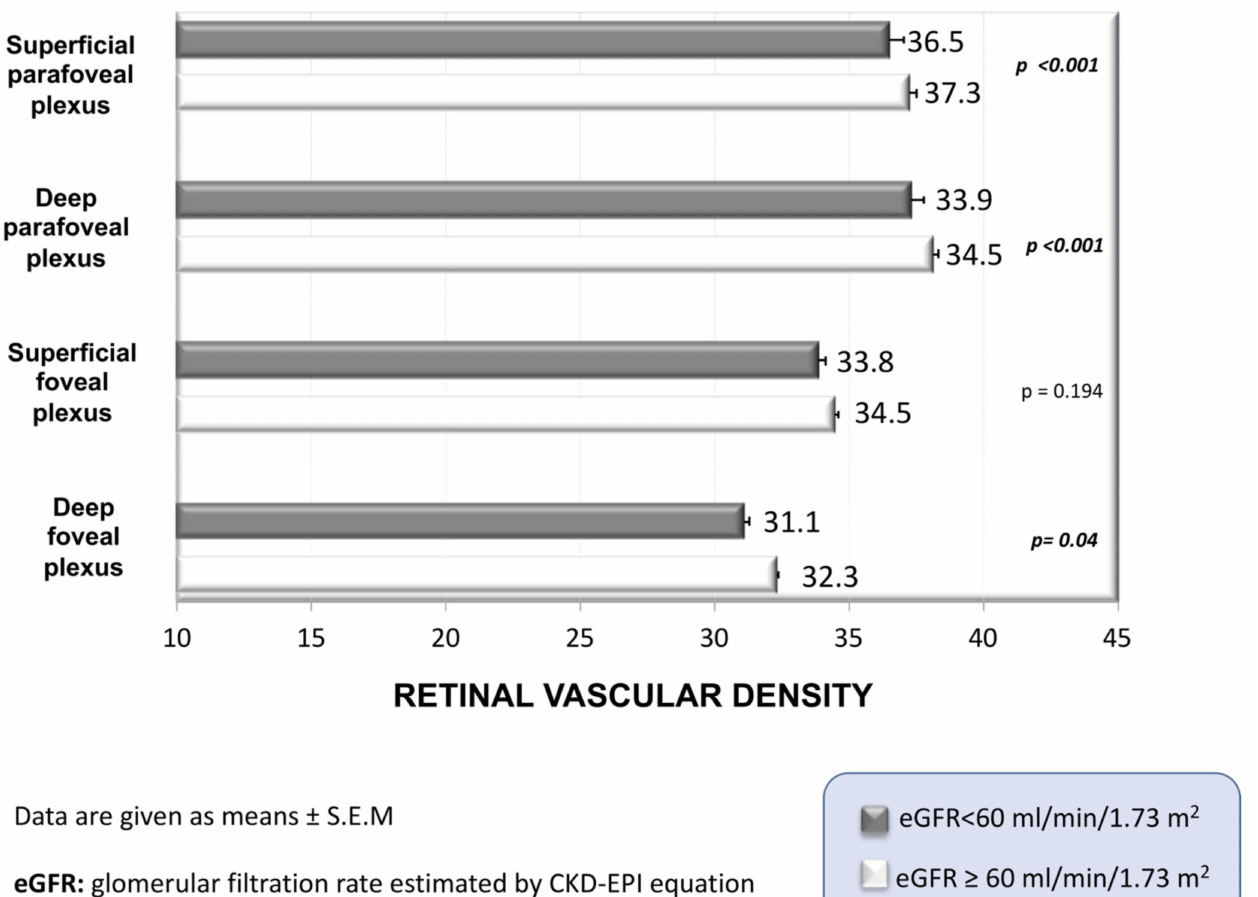
Figure 1. Differences in retinal vascular density between hypertensive subjects with eGFR above and below 60 mL/min/1.73 m 2